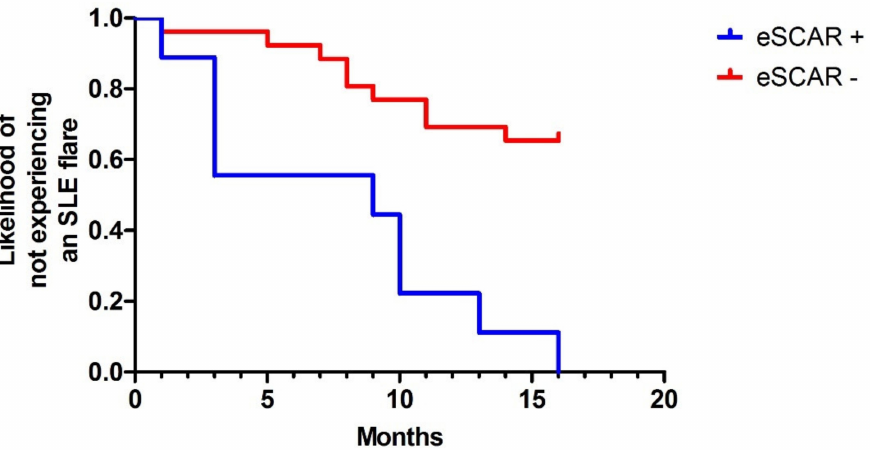
Figure 2. Survival curves for the status of SLE patients maintaining flare-free status over the follow- up period of the study. Hazard ratio for eSCAR-positive vs. eSCAR-negative patients: 4.91; 95% CI 1.43–16.83; p = 0.0001 (by the log-rank